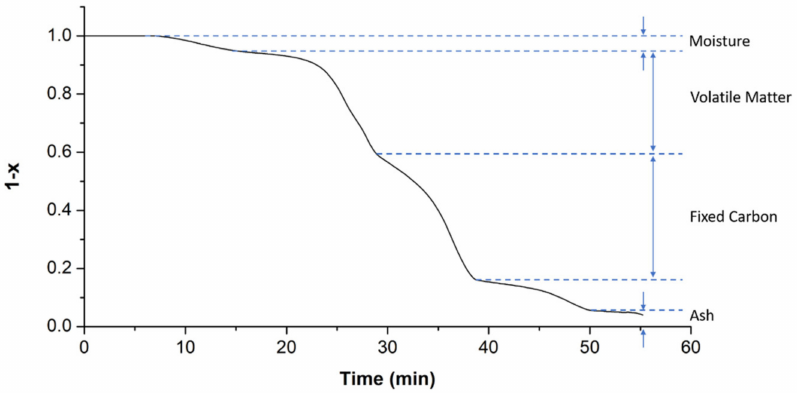
Figure 1. Thermogravimetric curve for proximate analysis of carob waste.